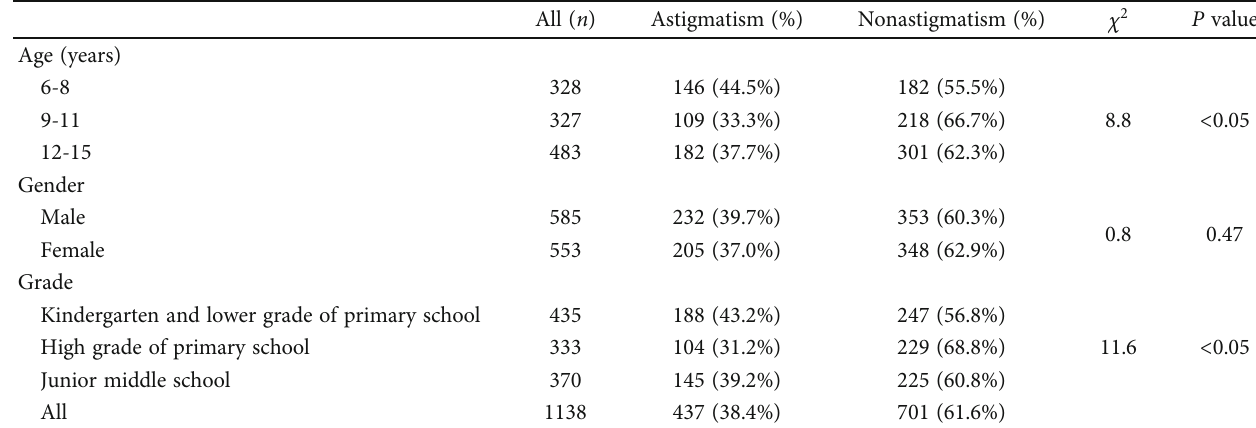
Table 4: Prevalence of astigmatism by age, gender, and